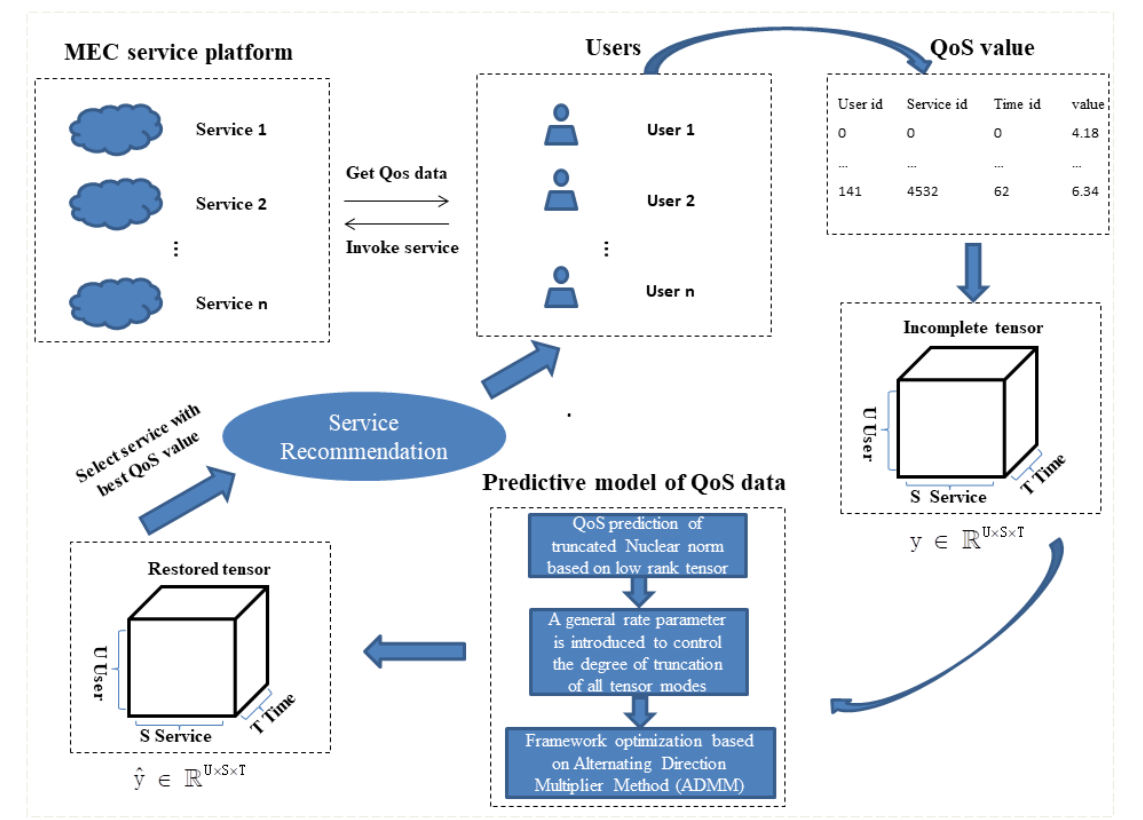
Figure 3. QoS prediction model based on TLTC.